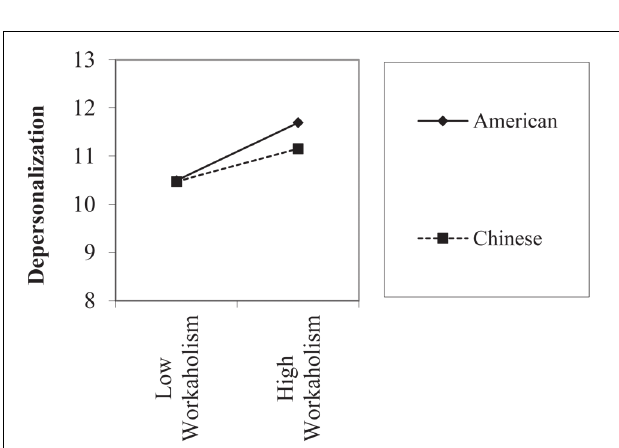
FIGURE 2 | Moderated regression analysis predicting personal accomplishment among participants in service